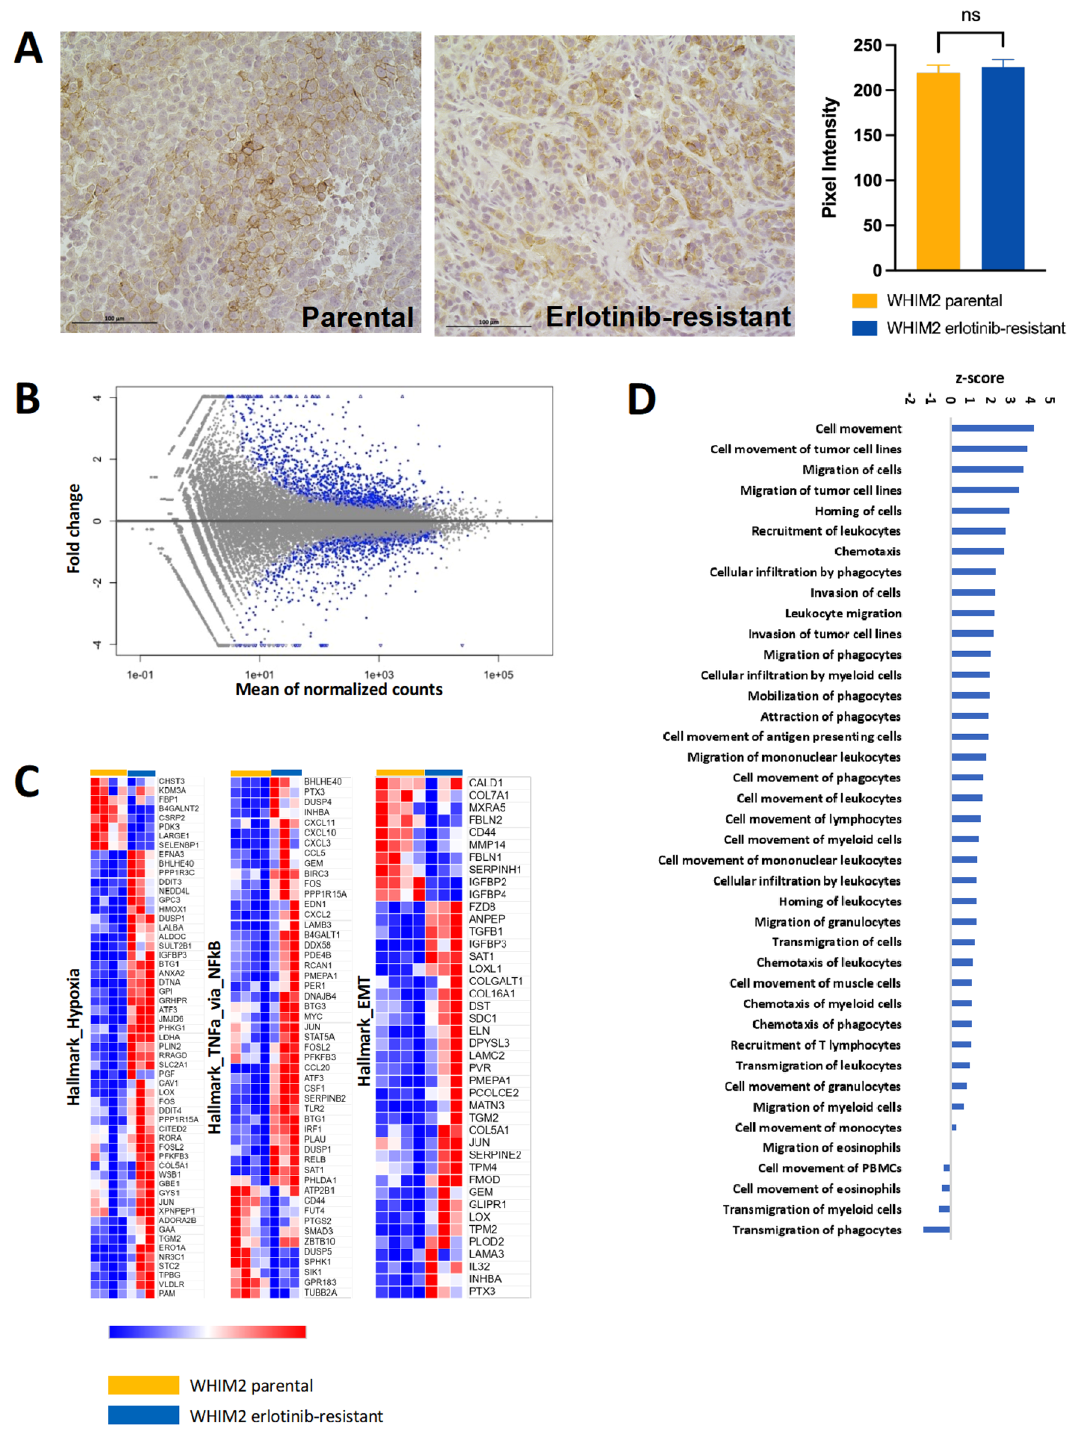
Figure 4. Assessment of erlotinib-resistance mechanisms in the WHIM2 PDX. ( A ) Immunohistochemical staining for EGFR on formalin-fixed, paraffin-embedded parental and erlotinib-resistant WHIM2 tumors and comparison of mean staining intensity of parental and erlotinib-resistant WHIM2 tumors ( P = 0.41); ( B ) Each point represents a single gene. Plot depicts fold change in gene expression in erlotinib-resistant tumors relative to vehicle tumors. Blue points represent genes that were significantly differentially expressed in the erlotinib- resistant WHIM2 tumor ( P < 0.05); ( C ) Examples of gene signatures upregulated in erlotinib-resistant tumors as determined by gene set enrichment analysis. Hallmark gene signatures for hypoxia, TNF-α via NFκB, and epithelial to mesenchymal transition are depicted; ( D ) Ingenuity Pathway Analysis identified significantly up- and down-regulated cellular gene expression programs in the WHIM2 erlotinib resistant